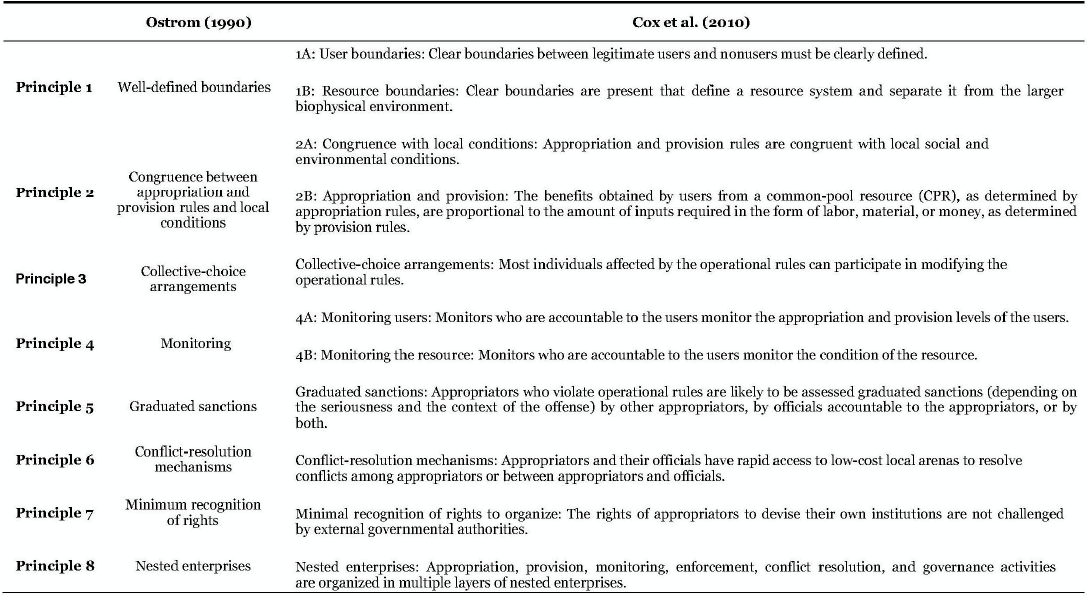
Figure 7. Design Principles for long-enduring institutions of adaptive management for the commons, adapted from Ostrom (1990), Cox et al. (2010) [41,42].